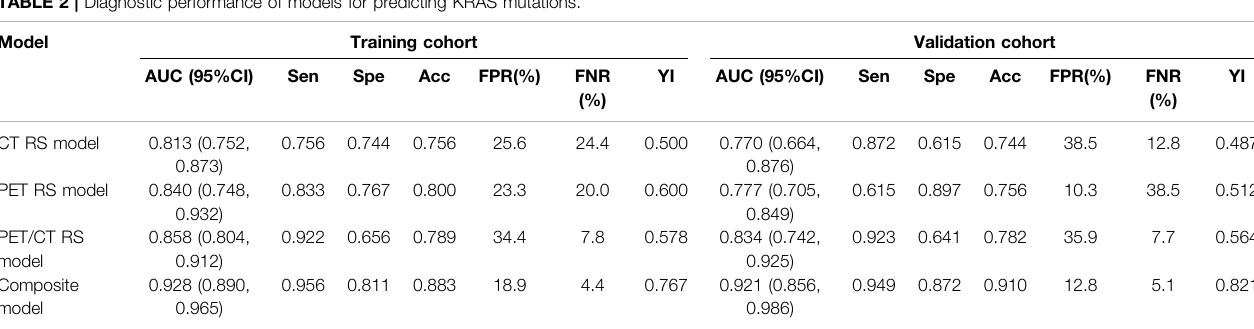
TABLE 2 | Diagnostic performance of models for predicting KRAS